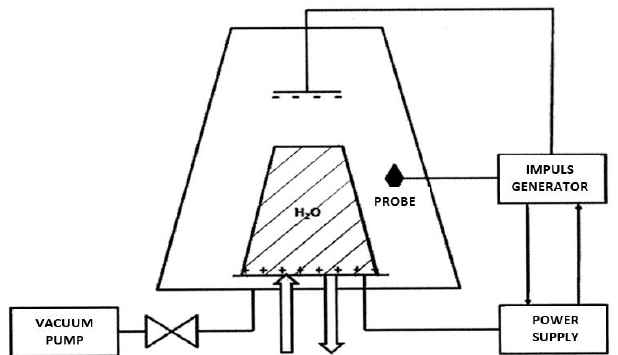
Figure 1. Scheme of the glow plasma (GP) generator and the mode of the treating water with it [35].